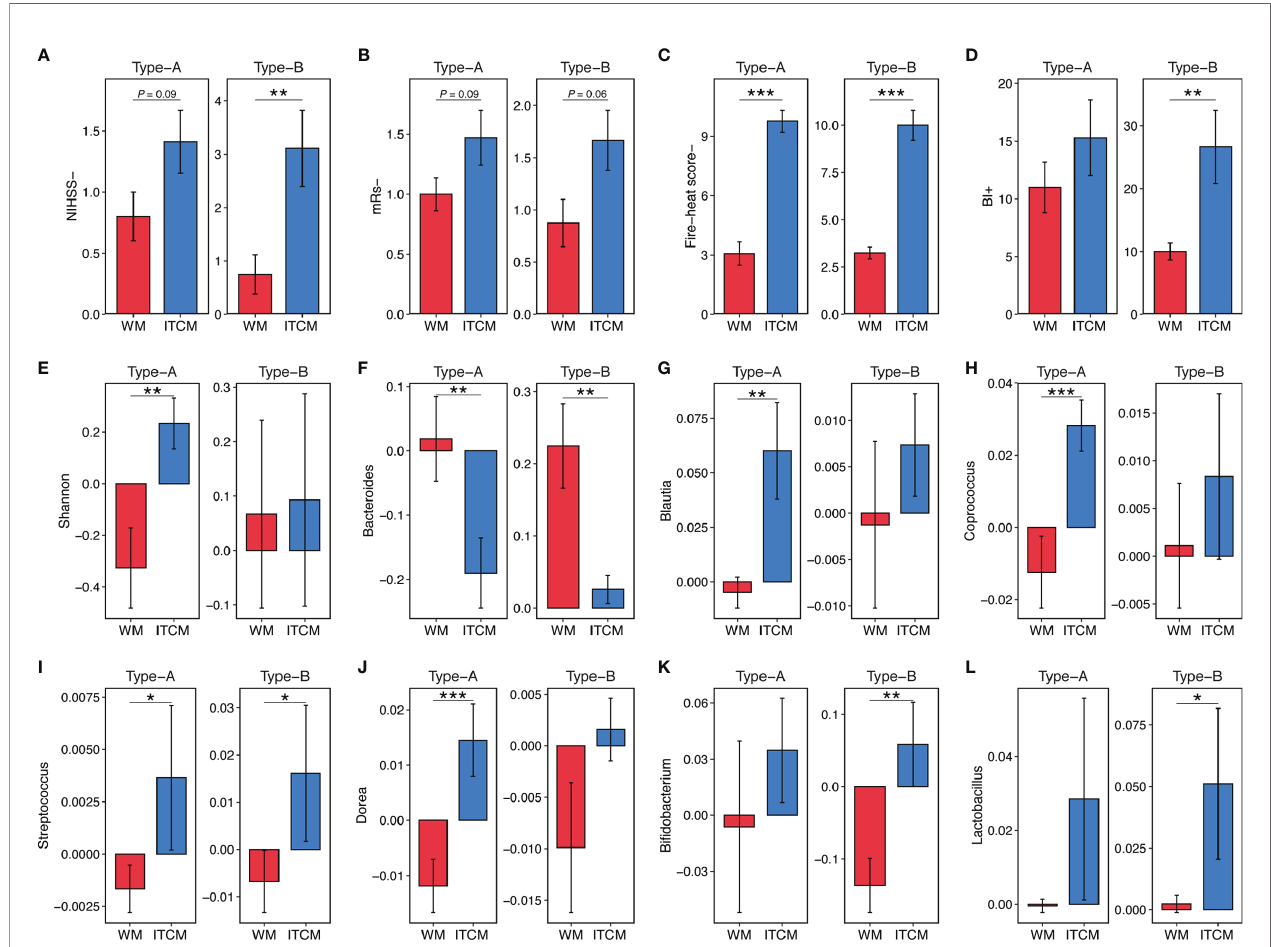
FIGURE 2 | The outcomes of AIS patients with different gut enterotypes and different treatments. (A – D) Clinical outcome of AIS patients with different gut enterotypes and different treatments. (E) Increase of microbial diversity (Shannon index) of AIS samples with different gut enterotypes and different treatments. (F – L) Increase of genus abundance in AIS samples with different gut enterotypes and different treatments. The colors of bars represented the treatment types. Red, Wm treatment; blue, ITCM treatment. NIHSS-, the decrease of NIHSS score; mRs-, the decrease of mRs score; BI+, the increase of BI score; fi re-heat score-, the decrease of fi re-heat score. * p ≤ 0.05, ** p ≤ 0.01, *** p ≤